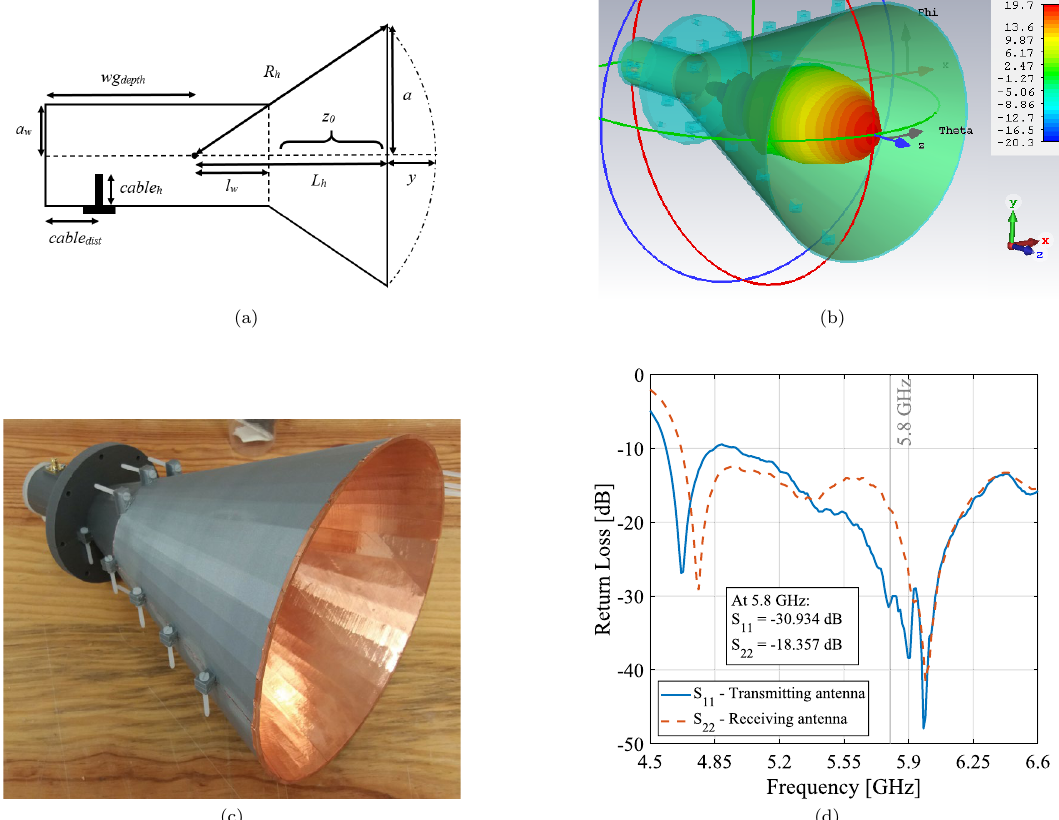
Figure 2. ( a ) Conical horn antenna schematic where a is the aperture radius, L h is the length between the aperture and the center of curvature and R h is the horn slant length. ( b ) Horn far field simulation result. ( c ) 3D-printed horn antenna. ( d ) Both horn antennas’ return losses.